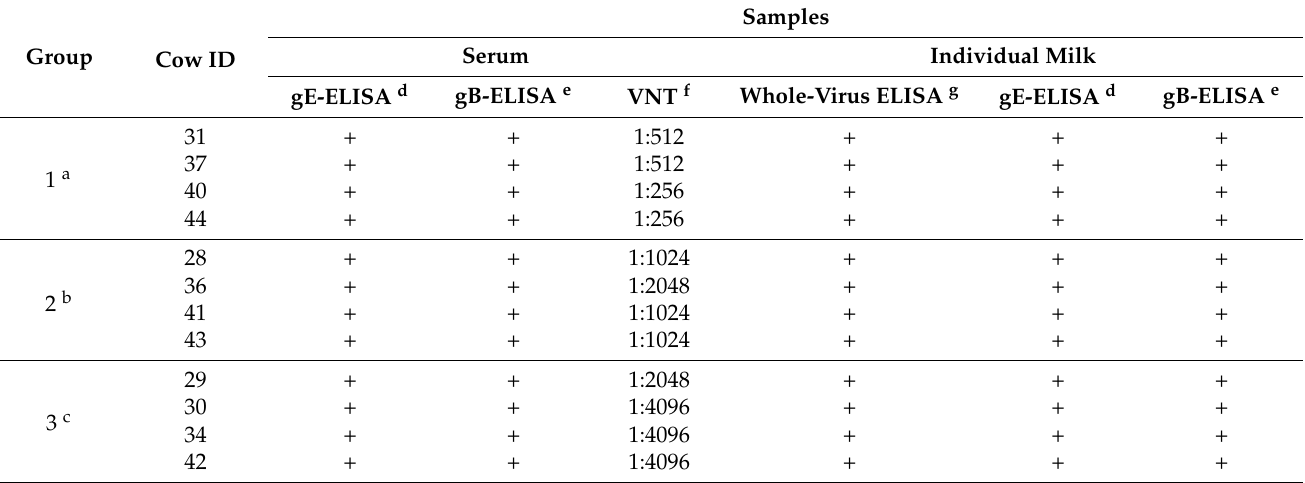
Table 2. Results obtained from serum and individual milk samples collected from twelve 4-year-old lactating cows during an IBR outbreak that occurred in 2018 in central Italy.